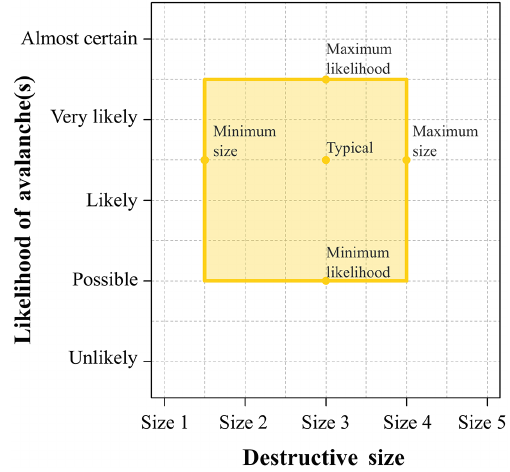
Figure 2. Example hazard chart summarizing avalanche hazard conditions using the likelihood and destructive size assessments for an avalanche problem. The points in the middle are the typical value of likelihood and destructive size, while the outer edges are the max- imum and minimum values which represent the associated uncer- tainty in